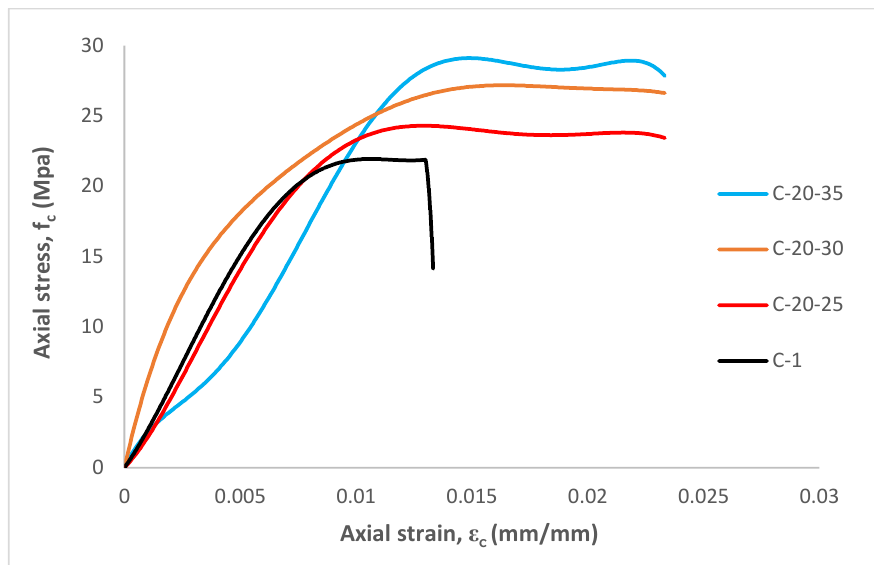
Figure 6. Stress-strain curves of specimens.